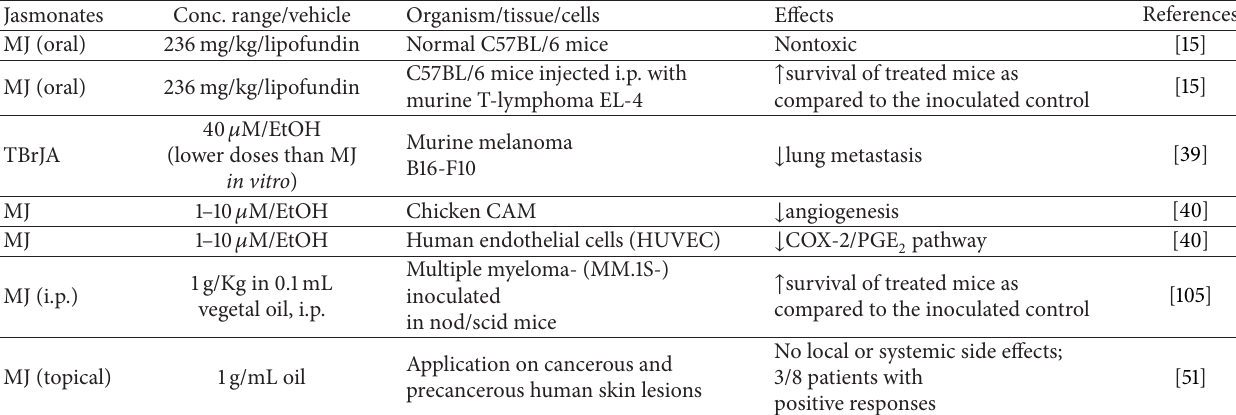
Table 2: Effect in vivo of natural and synthetic jasmonates